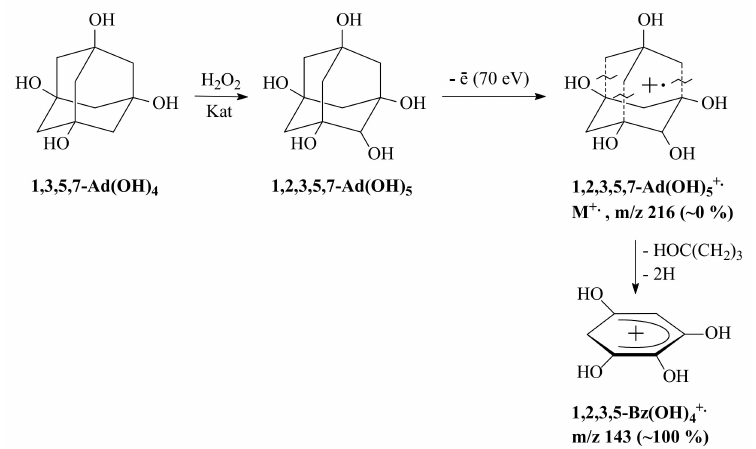
Scheme 5. Fragmentation of the molecular ion of 0 pentaol.